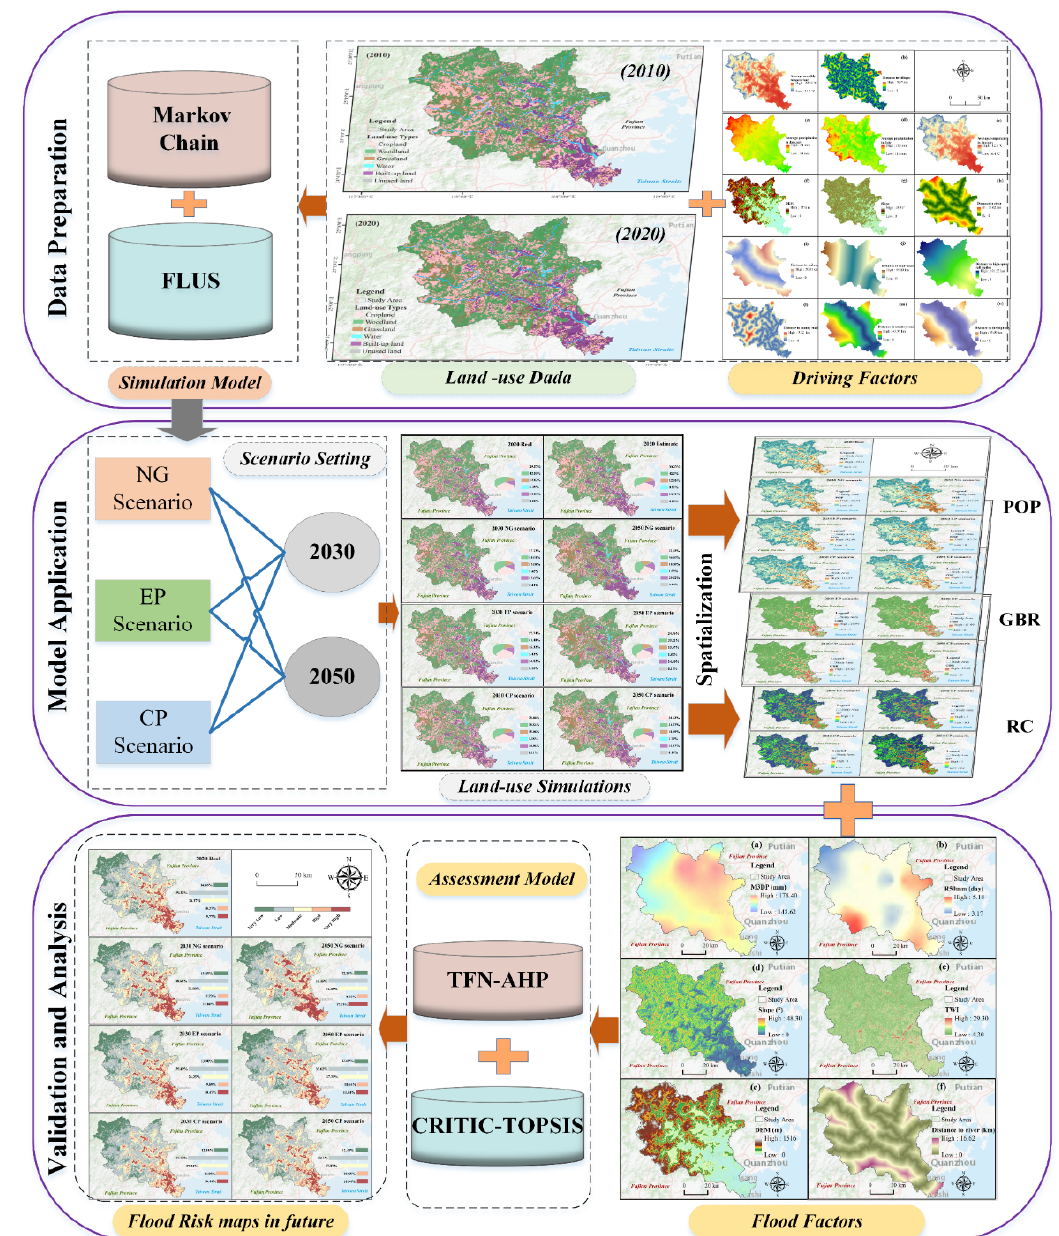
Figure 3. The workflow of dynamic assessment of the flood risk of Jinjiang Basin in this